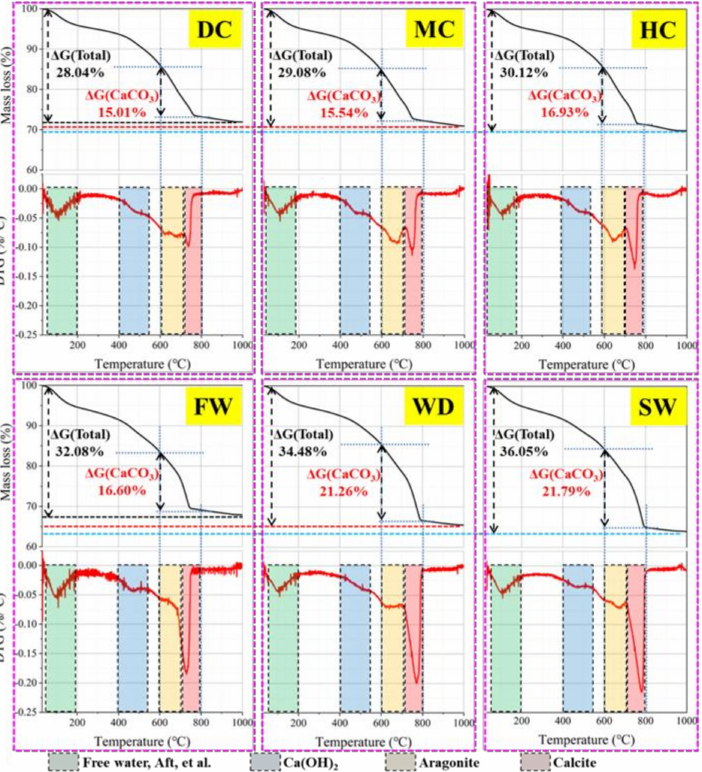
Figure 15. TG analysis of self-sealing products for samples cured in different